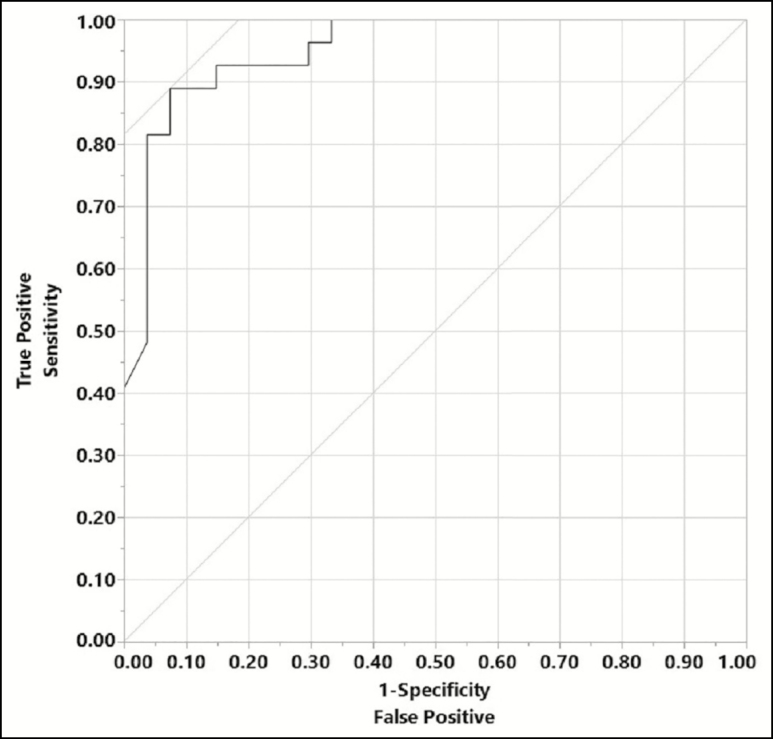
Receiver operating characteristic curve for neutrophil percentage (PMN%). Area under curve (AOC) = 0.95.